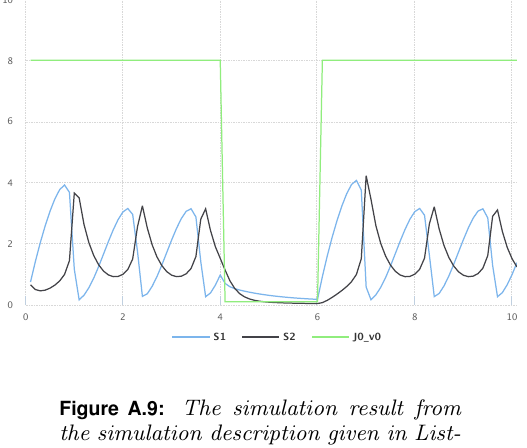
Figure A.10: Simulation with tellurium